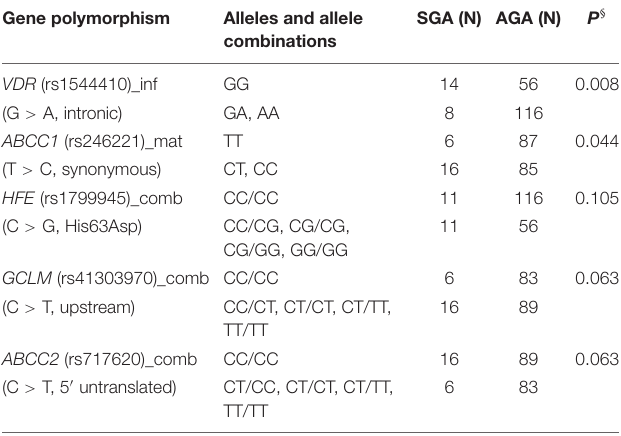
TABLE 8 | Genotypes associated with birth outcome in bivariate